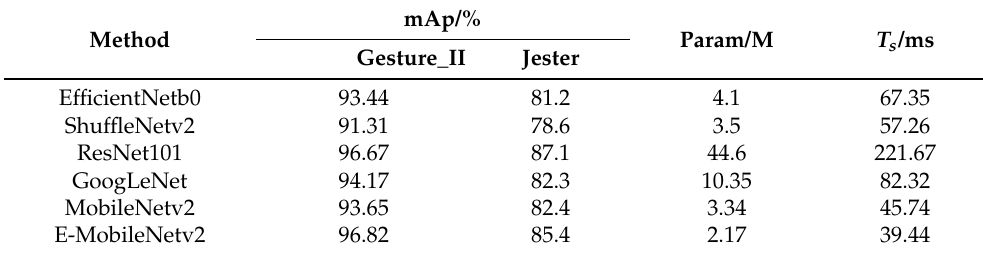
Table 4. Comparison of results of different network